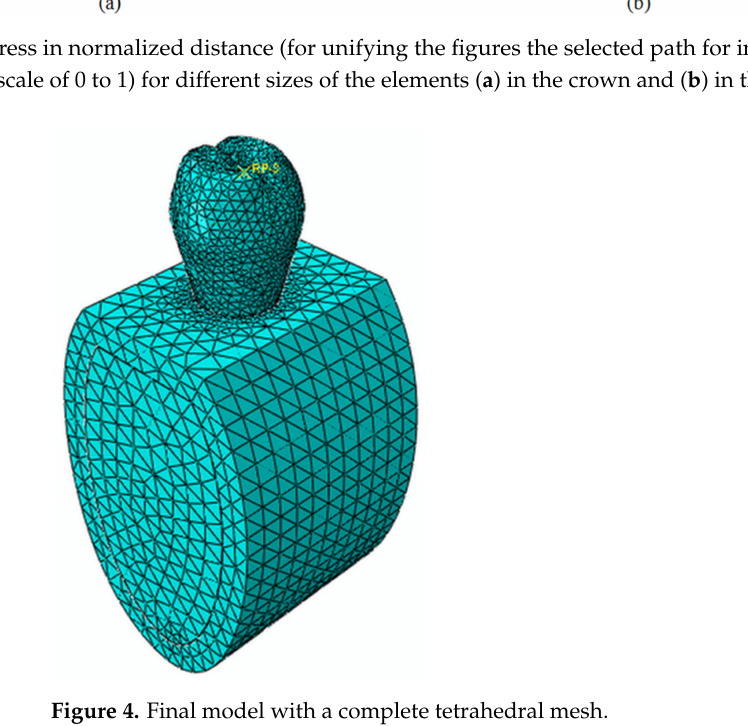
Figure 4. Final model with a complete tetrahedral